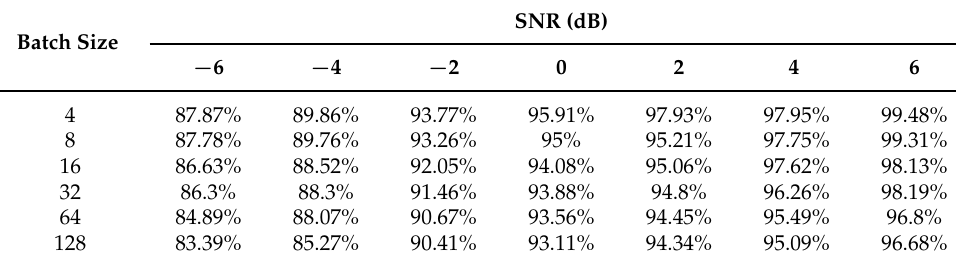
Table 3. The accuracy of attention EfficientNet under different SNR and batch